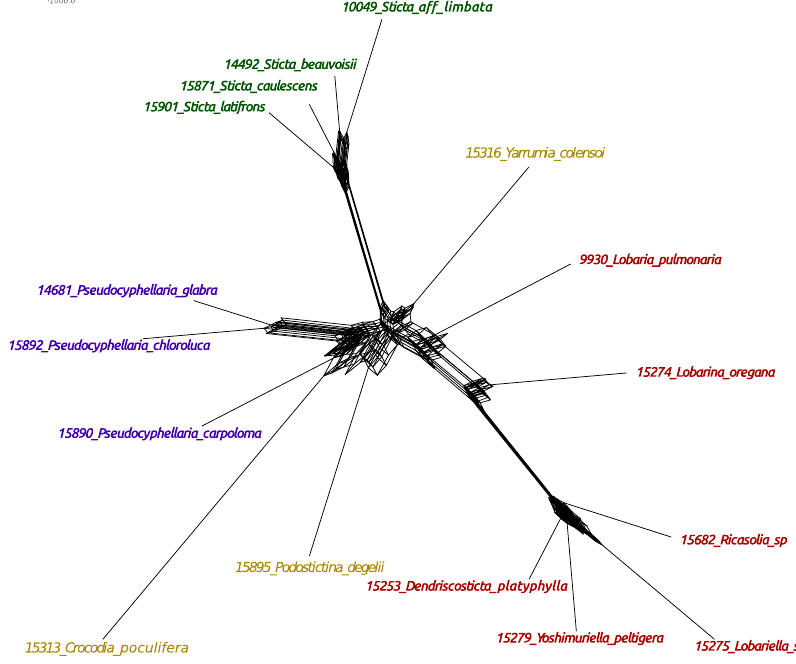
Figure 6. A SplitsTree network estimated with the MedianNetwork method. The network shows relationships of genera based on the 297 × 17 nuc dataset with no outgroup.